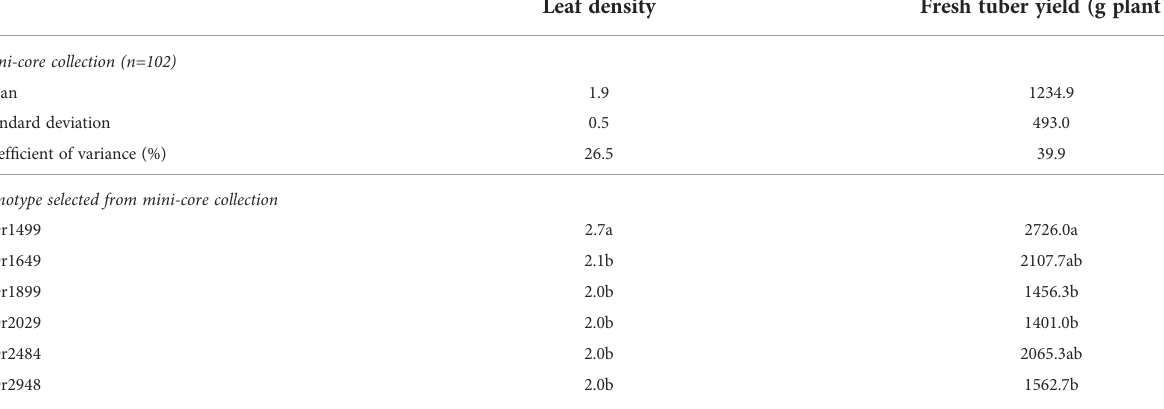
TABLE 1 Variation in tuber yield (g plant -1 ) and leaf density in the white Guinea yam ( Dioscorea rotundata ) mini-core collection and the distribution of the used